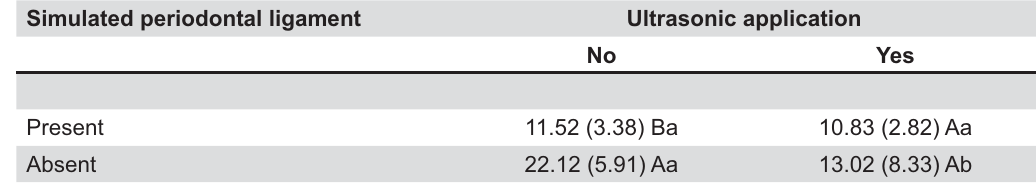
Means followed by different upper case letters in columns and lowercase letters in rows differ from each other (Tukey’s (cid:1)(cid:2)(cid:3)(cid:1)(cid:4)(cid:5)(cid:6)(cid:7)(cid:8)(cid:5)(cid:9)(cid:10)(cid:11)(cid:12)(cid:13)(cid:2)(cid:11)(cid:9)(cid:2)(cid:5)(cid:14)(cid:2)(cid:15)(cid:2)(cid:14)(cid:16)(cid:17)